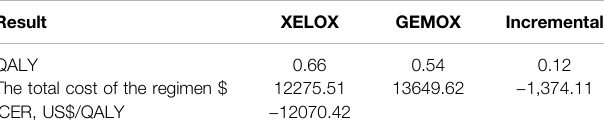
TABLE 4 | Base case results in